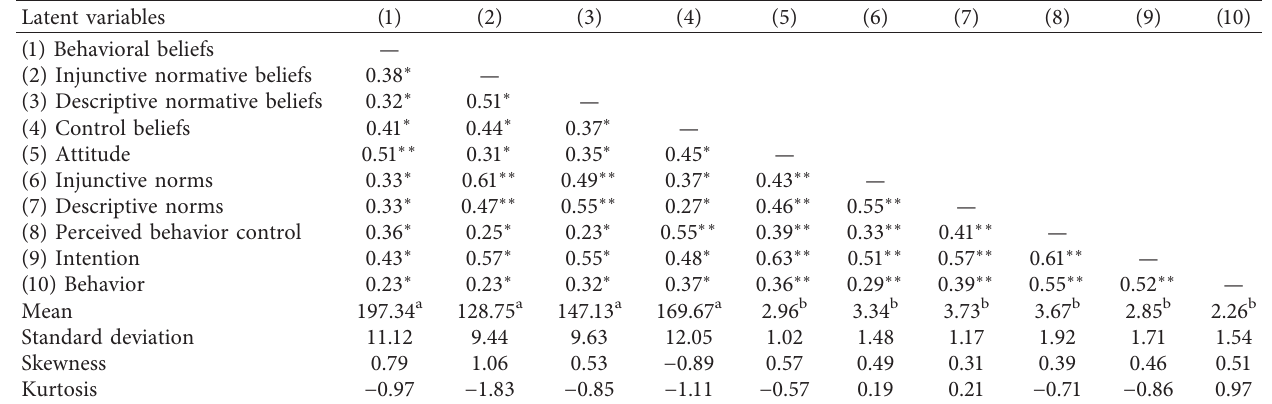
Table 4: Correlations among measured variables and descriptive